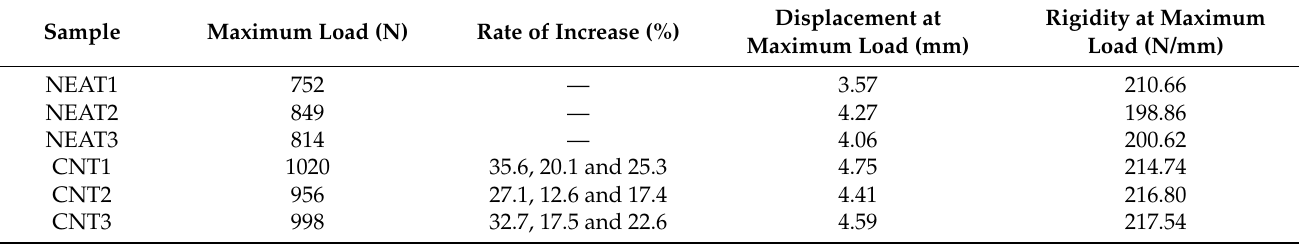
Table 3. The maximum bending load and vertical displacements of samples.